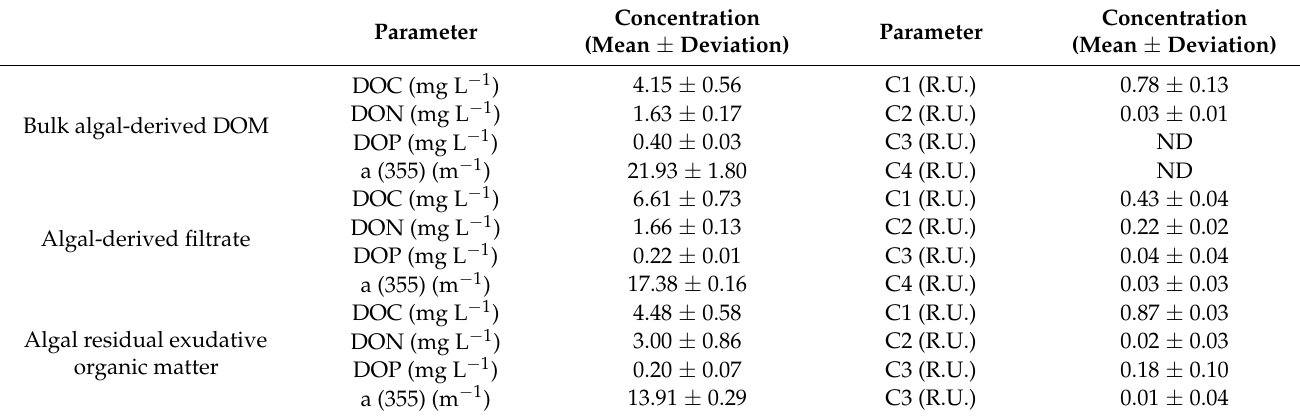
Table 1. Physicochemical properties of bulk algal-derived dissolved organic matter (DOM), algal- derived filtrate, and algal residual exudative organic matter. ND—not determined. DOC—dissolved organic carbon; DON—dissolved organic nitrogen; DOP—dissolved organic